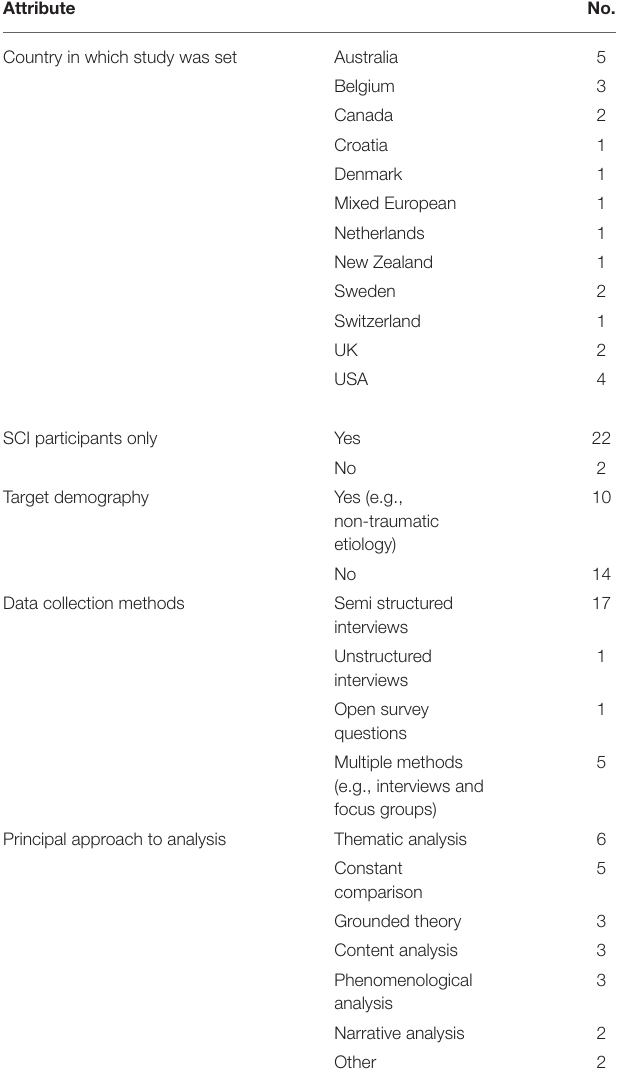
TABLE 1 | Summary of attributes of articles in synthesis ( n = 24). Attribute No. Country in which study was